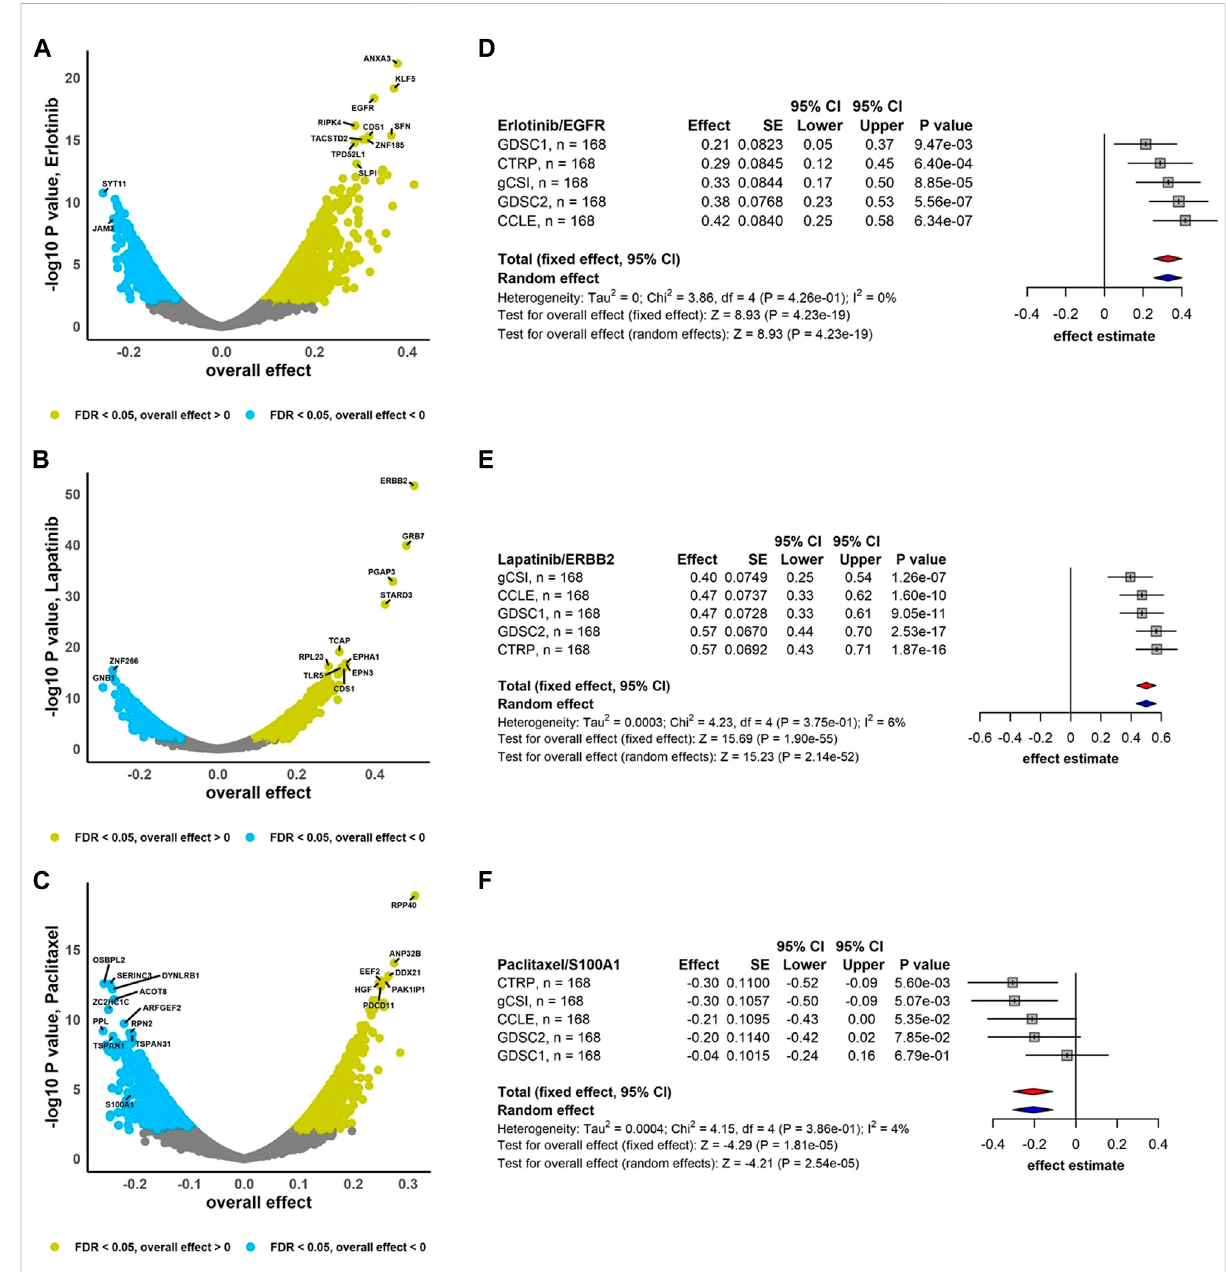
FIGURE 3 Pan-cancer independent meta-analyses. Volcano plots show genes associated with drug response using RE meta-analysis model and forest plots illustrate overall effects estimate using FE (red diamond) and RE (blue diamond) meta-analysis models using drugs (A) Erlotinib, (B) Lapatinib, and (C) Paclitaxel. DL approach was applied to estimate heterogeneity across